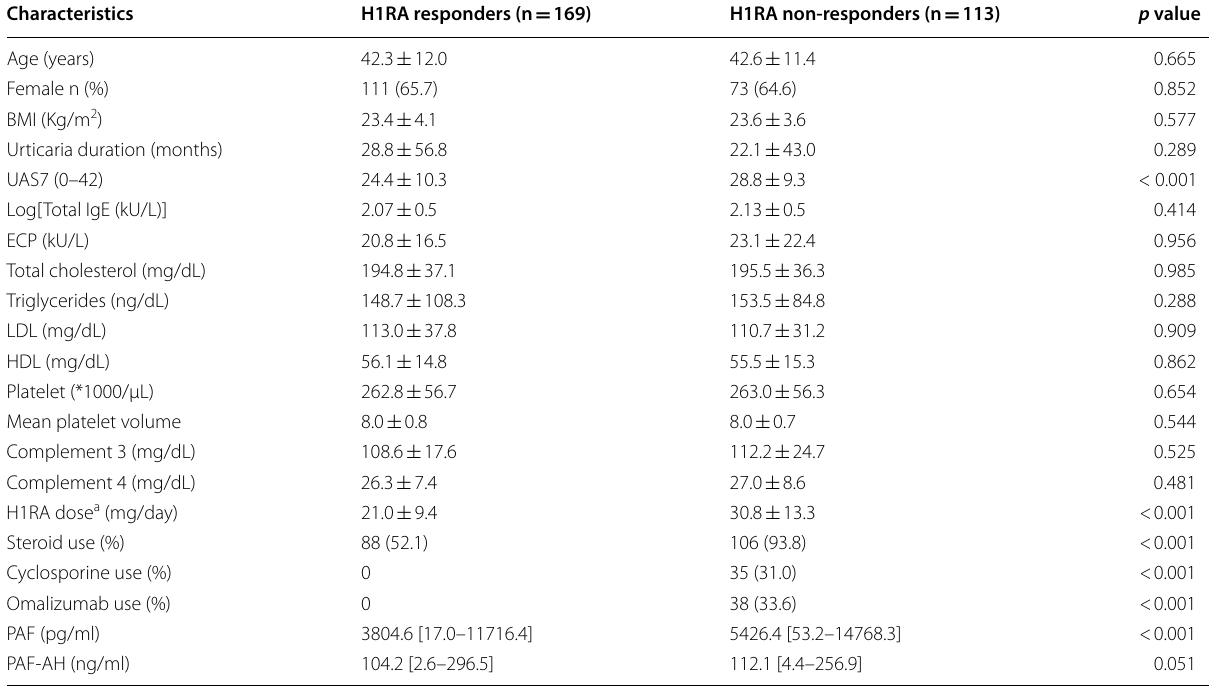
Table 2 Clinical characteristics of H1RA responders and H1RA non-responders among CSU patients